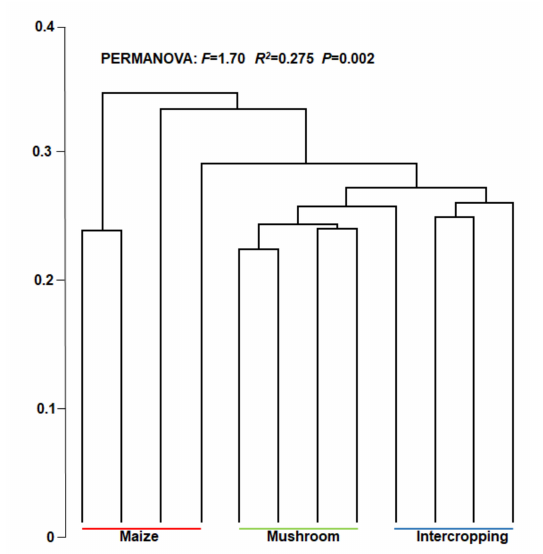
Figure 5. Hierarchical cluster analysis of soil bacterial communities based on the NMDS dissimilarity matrix among maize monoculture, mushroom monoculture and intercropping. Permutational multivariate analysis of variance (PERMANOVA) was adopted to compare community composition on three treatments. The number of replicates per treatment is 4 ( n = 4).